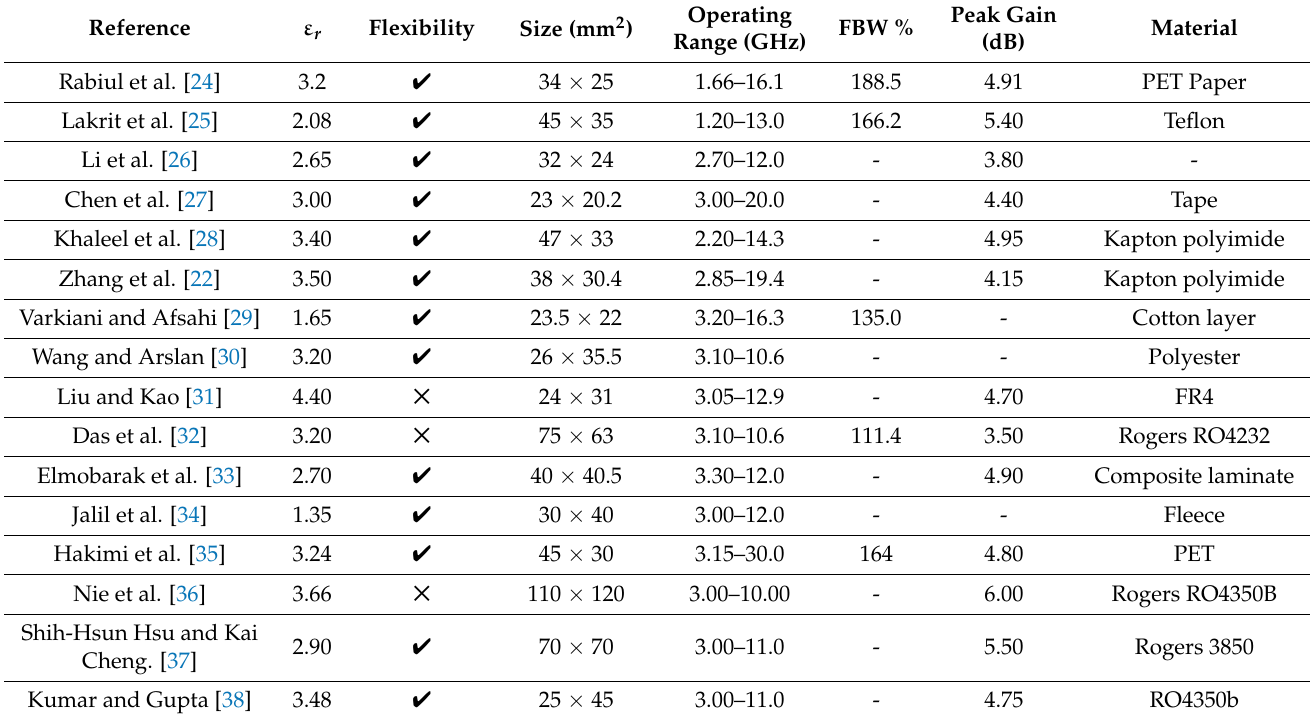
Table 1. Literature summary of the performance of different CPW-fed antennas for wide frequency